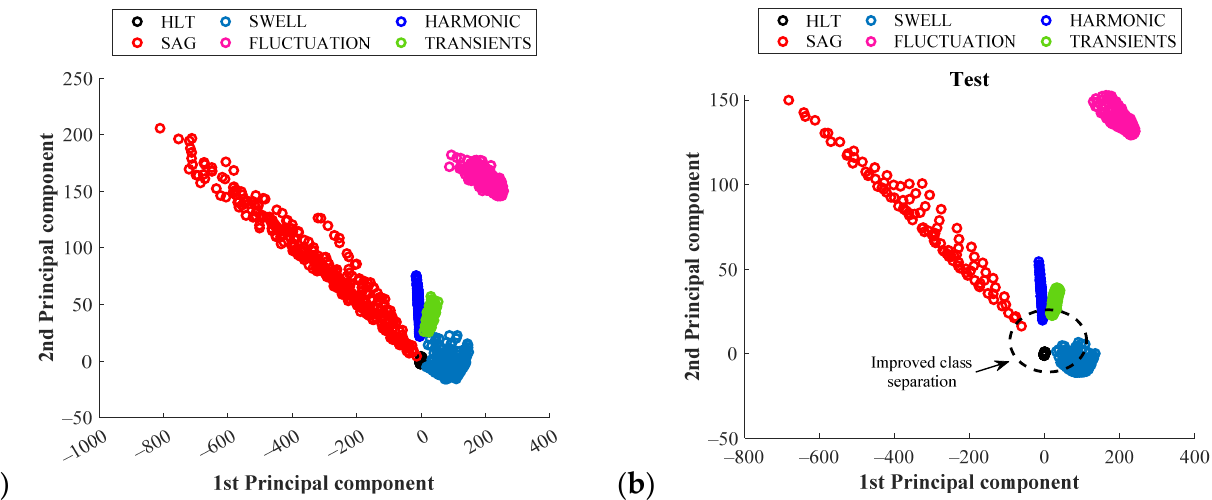
Figure 6. 2- d visual representation of the data distribution for all the assessed conditions achieved by the PCA technique during the analysis of each characteristic feature matrices for: ( a ) the estimated features for FD and ( b ) the subset of selected features for FD.